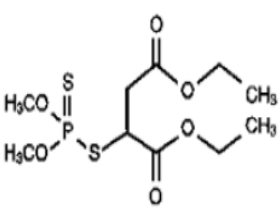
Figure 1. Structure of